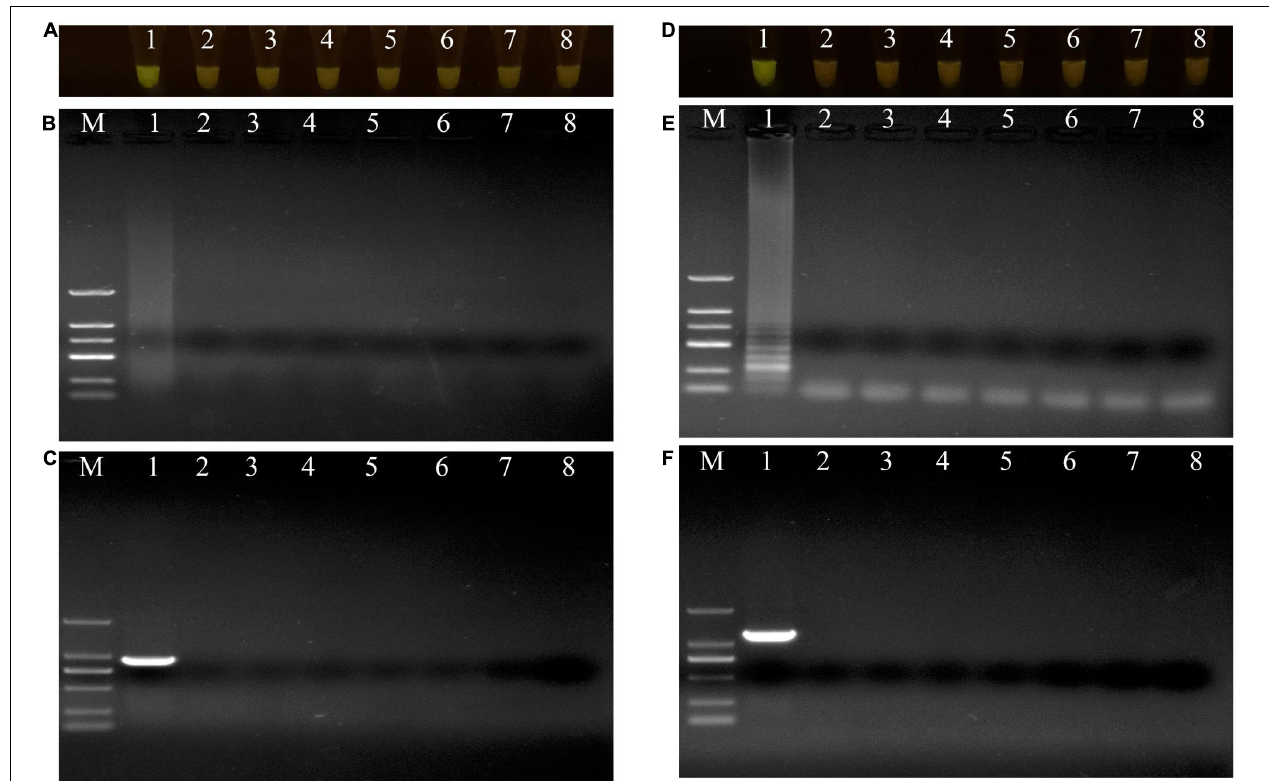
FIGURE 3 | Evaluations of specificity of loop-mediated isothermal amplification (LAMP) and polymerase chain reaction (PCR) assay. (A–C) Evaluation of specificity of LAMP and PCR assay for Pseudomonas aeruginosa X1 and the other close bacterial strains. Lane M: DNA marker DL2000; number 1–8: Pseudomonas aeruginosa X1, Pseudomonas syringae DC3000, Pseudomonas putida X13, Pseudomonas psychrotolerans 1.15631, Pseudomonas nitroreducens 1.1796, Pseudomonas. toyotomiensis 1.532, Pseudomonas fluorescens 1.4528, ddH 2 O. (D–F) Evaluation of specificity of LAMP and PCR assay for Serratia marcescens X2 and the other close bacterial strains. Lane M: DNA marker DL2000; number 1–8: Serratia marcescens X2, Serratia liquefaciens BNCC 186068, Serratia odorifera Bio-67784, Serratia plymuthica 1.996, Serratia fonticola 1.995, Serratia nematodiphla 1.6853, Serratia rubidaea 1.10839, ddH 2 O. (A , D) LAMP products visualized with gelgreen. Under daylight, positive reactions are shown by bright green color, and negative reactions are dark red color. (B , E) Determining the visual LAMP products by agarose gel electrophoresis. (C , F) Determining the PCR products by agarose gel